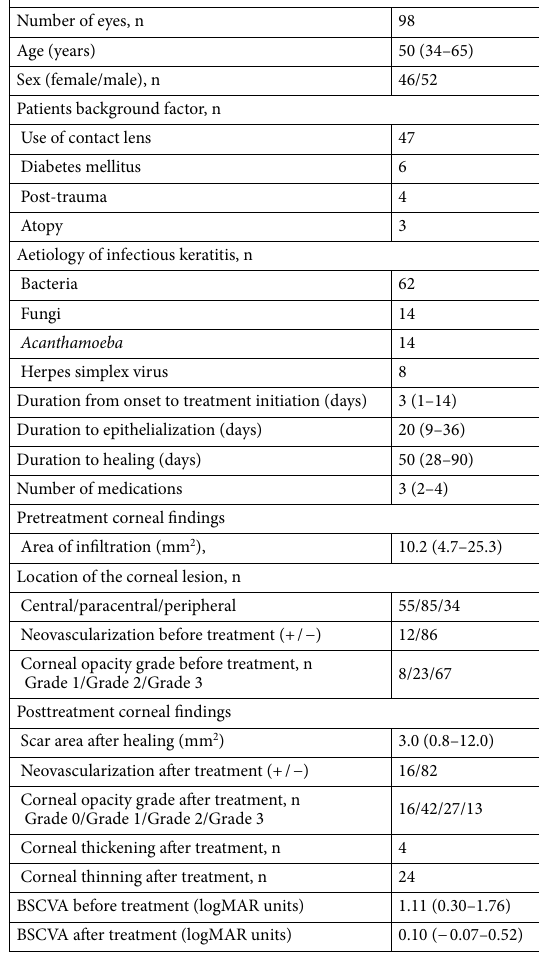
Table 1. Patient characteristics. The values are presented as median (interquartile range). The location of the corneal lesion was defined as 3 mm from centre of the cornea for central, within 3–6 mm for paracentral, and beyond 6 mm for peripheral. BSCVA best spectacle-corrected visual acuity, logMAR logarithm of the minimum angle of